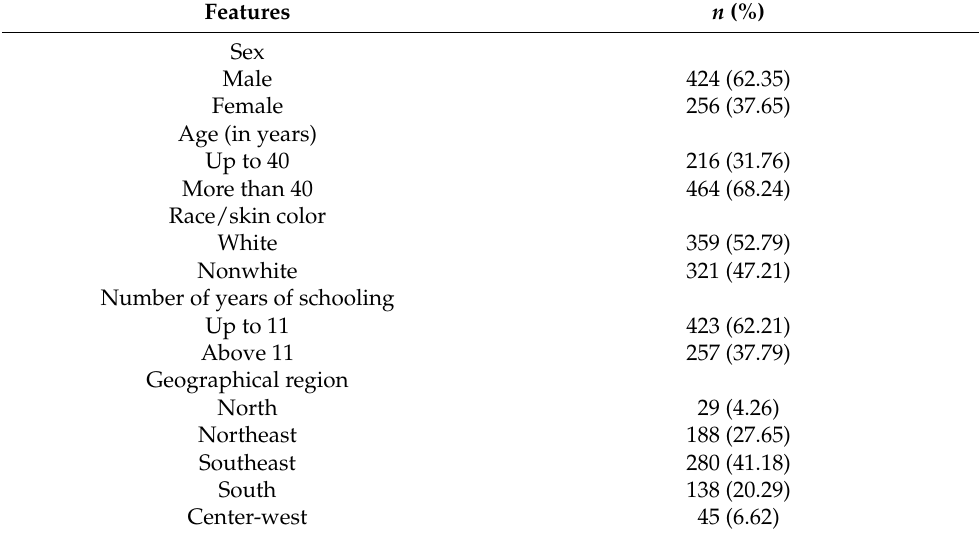
Table 1. Sociodemographic characteristics of workers with disabilities due to WRMDs who had undergone rehabilitation through Social Security and then returned to the formal employment market. Brazil, 2014–2018 ( n =